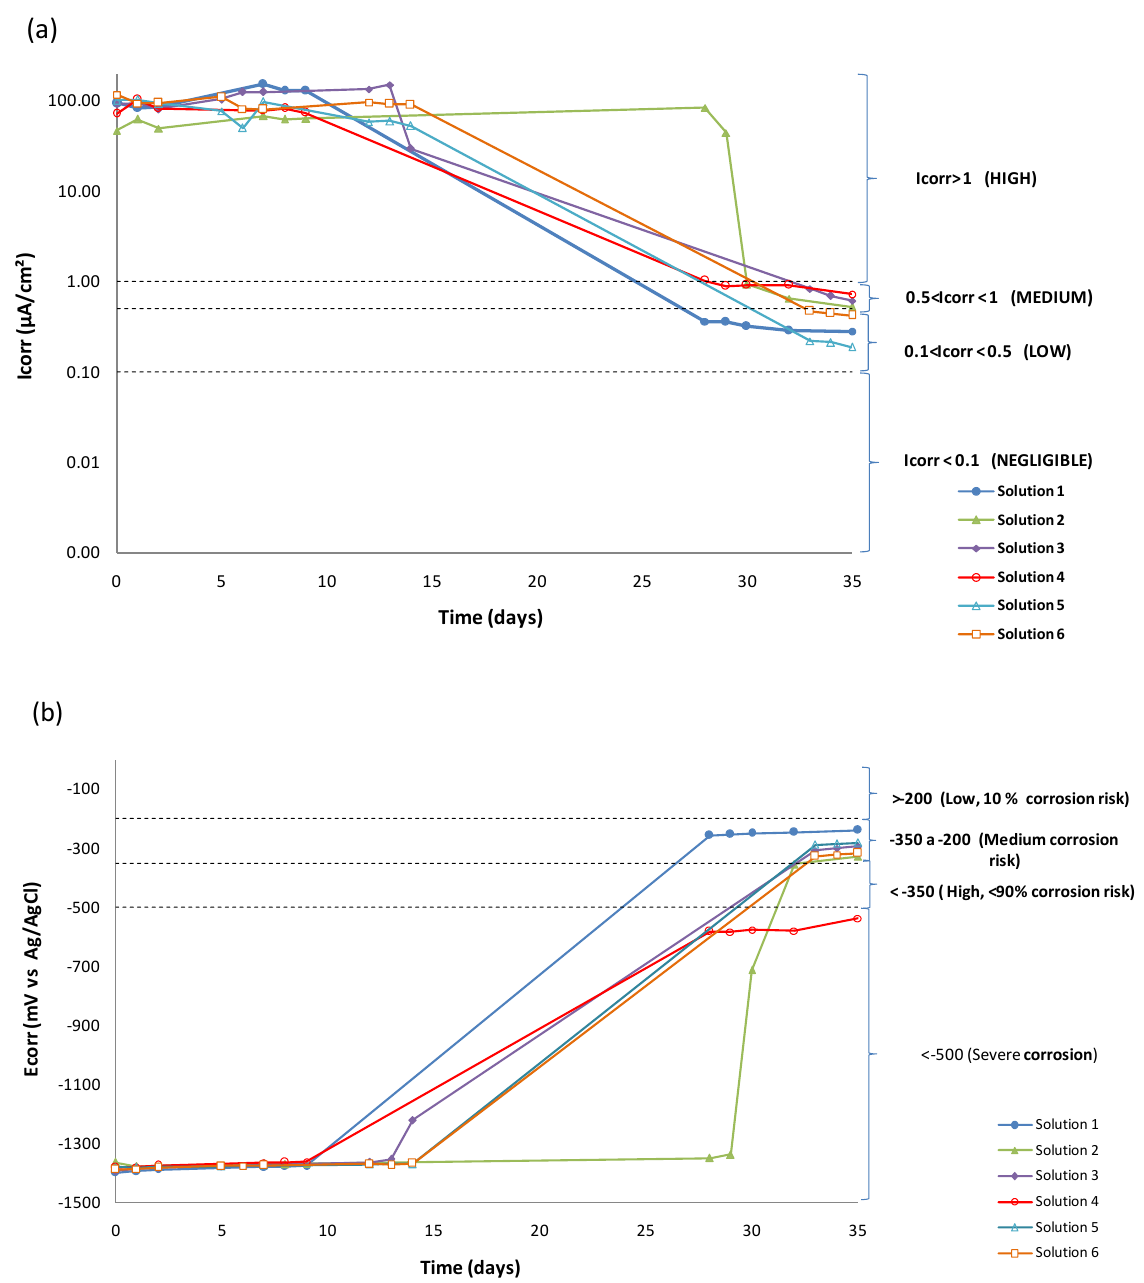
Figure 3. Evolution in time of ( a ) I corr and ( b ) E corr of the wires. Starting point results were very electronegative for all solutions (–1.4 V) and showed corrosion current densities around 100 µA/cm 2 . After 35 days of testing, the potential increased to less electronegative values, higher than −0.3 V (except for Solution 4). Corrosion current density decreased to 0.5 µA/cm 2 . These values of E corr were also recorded in other works. In particular, at a pH value of 13, Zn is actively dissolved, giving rise to a soluble phase of Zn(OH) 42− in the potential range between −1.35 to −1.45 VSCE [29]. The corrosion current density decreases until they reach values between 0.1 and 1 µA/cm 2 . The solution containing only sulfate ions SO 42 − (Solution 1) begins with active I corr (97.24 µ A/cm 2 ) and a fairly electronegative E corr ( − 1.4 V). Initial values recorded for E corr and I corr indicate that the galvanized layer upon contact with the alkaline medium dissolves anodically, with consequent evolution of hydrogen on the galvanized surface